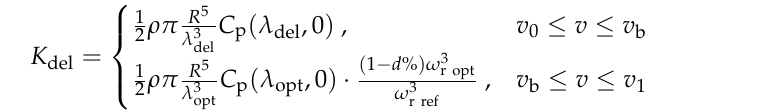
Figure 3. Principle of the cooperative deloading control.